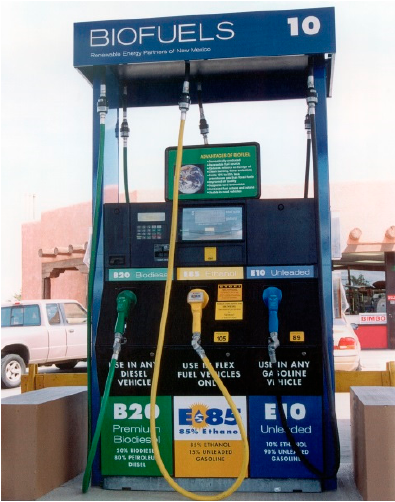
Figure 2. A biofuel station in the United States (B20: 20% biofuel blended with 80% diesel; E85: 85% ethanol blended with 15% gasoline; E10: 90% ethanol blended with 10% gasoline).